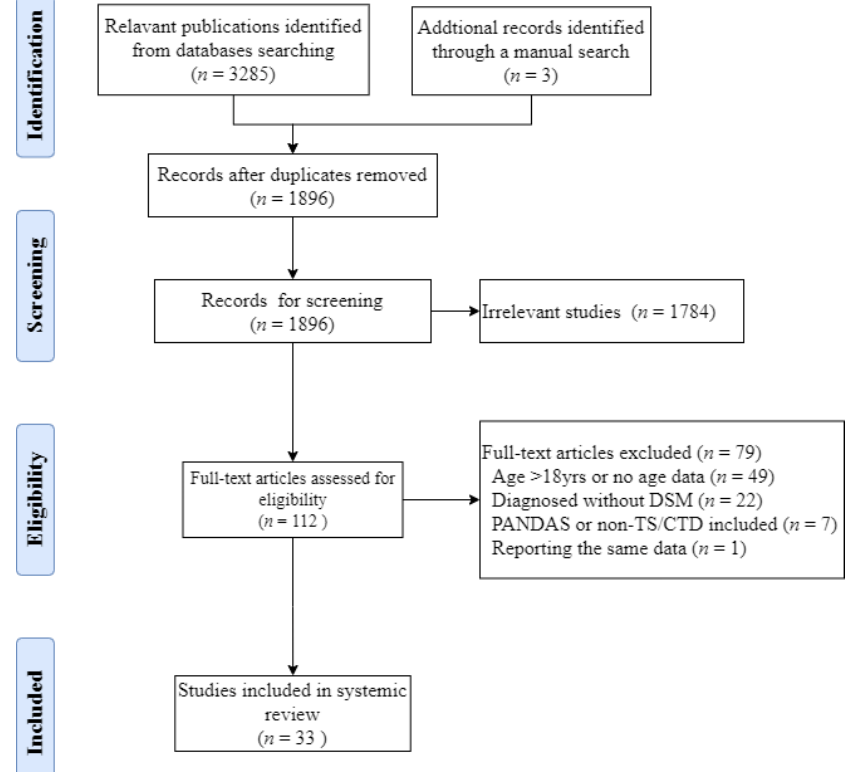
Figure 1. PRISMA flow diagram of study selection.